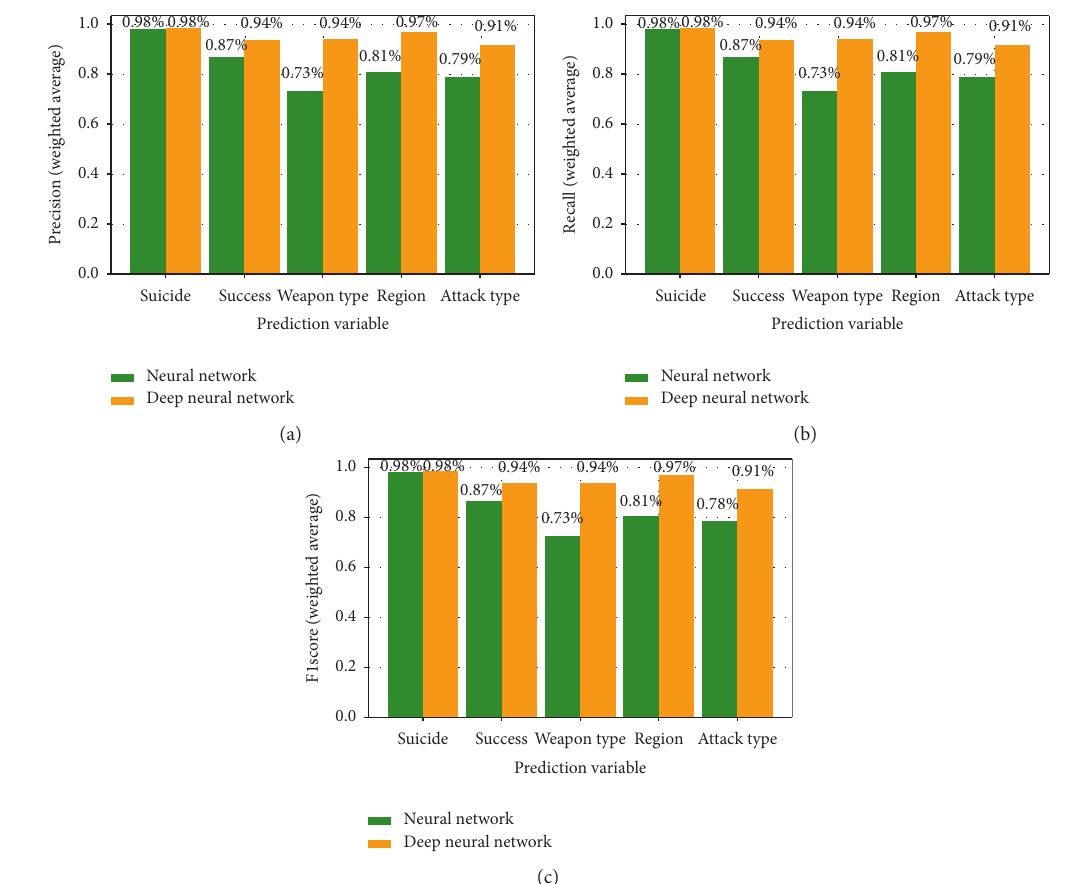
Figure 6: Precision, recall, and F1-Score by neural network and deep neural network in making predictions of suicide, success, weapon type, region, and attack type. (a) Precision by neural network and deep neural network. (b) Recall by neural network and deep neural network. (c) F1-Score by neural network and deep neural